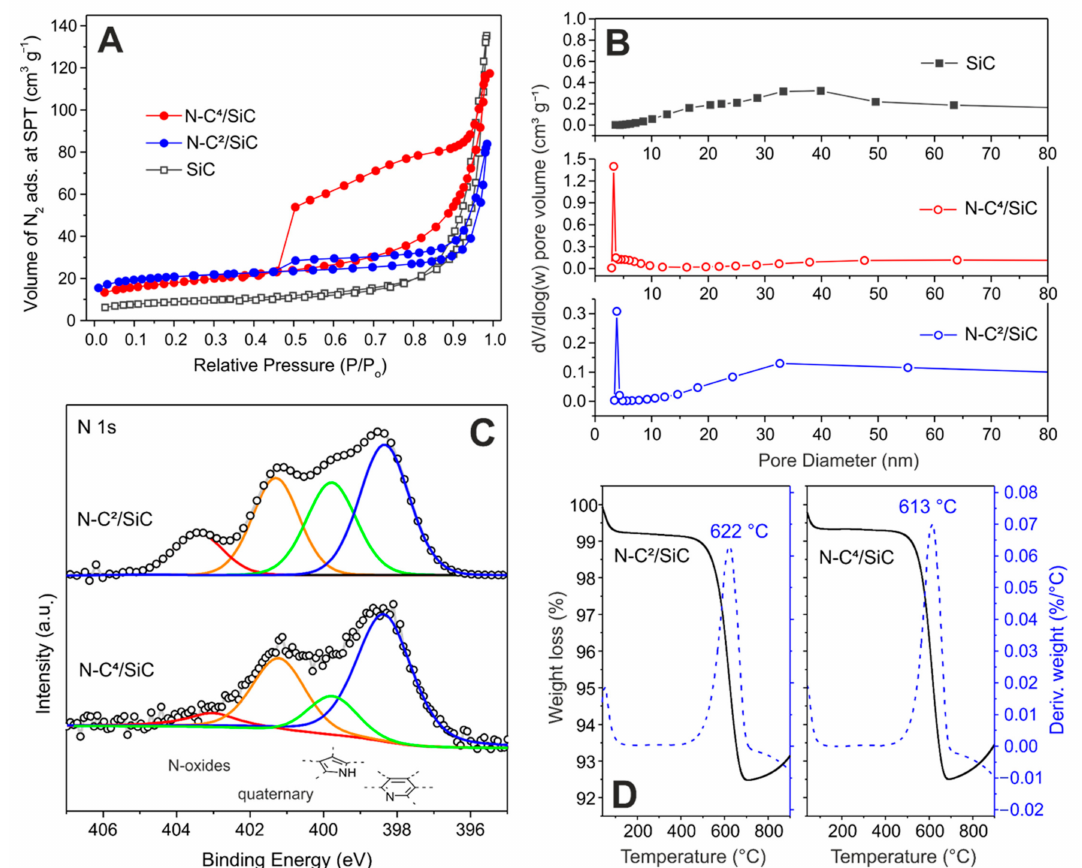
Figure 2. ( A ) N 2 adsorption-desorption isotherm linear plot of SiC (light grey curve), N-C 2 /SiC (blue curve) and N-C 4 /SiC samples (red curve) recorded at 77 K along with ( B ) the respective pore-size distributions measured (BJH method). ( C ) High- resolution XPS N 1s core level region of N-C 2 /SiC (up) and N-C 4 /SiC (down) at comparison, along with the relative curves fittings. ( D ) Thermogravimetric/derivative of the thermogravimetric curves (TG/DTG) profiles of N-C 2 /SiC (left-side hand) and N-C 4 /SiC (right-side hand) at comparison. Weight loss is measured arbitrarily in the 200–700 ◦ C temperature range. Operative conditions: Air, 50 mL/min; heating rate: From 40 to 900 ◦ C at 10 ◦